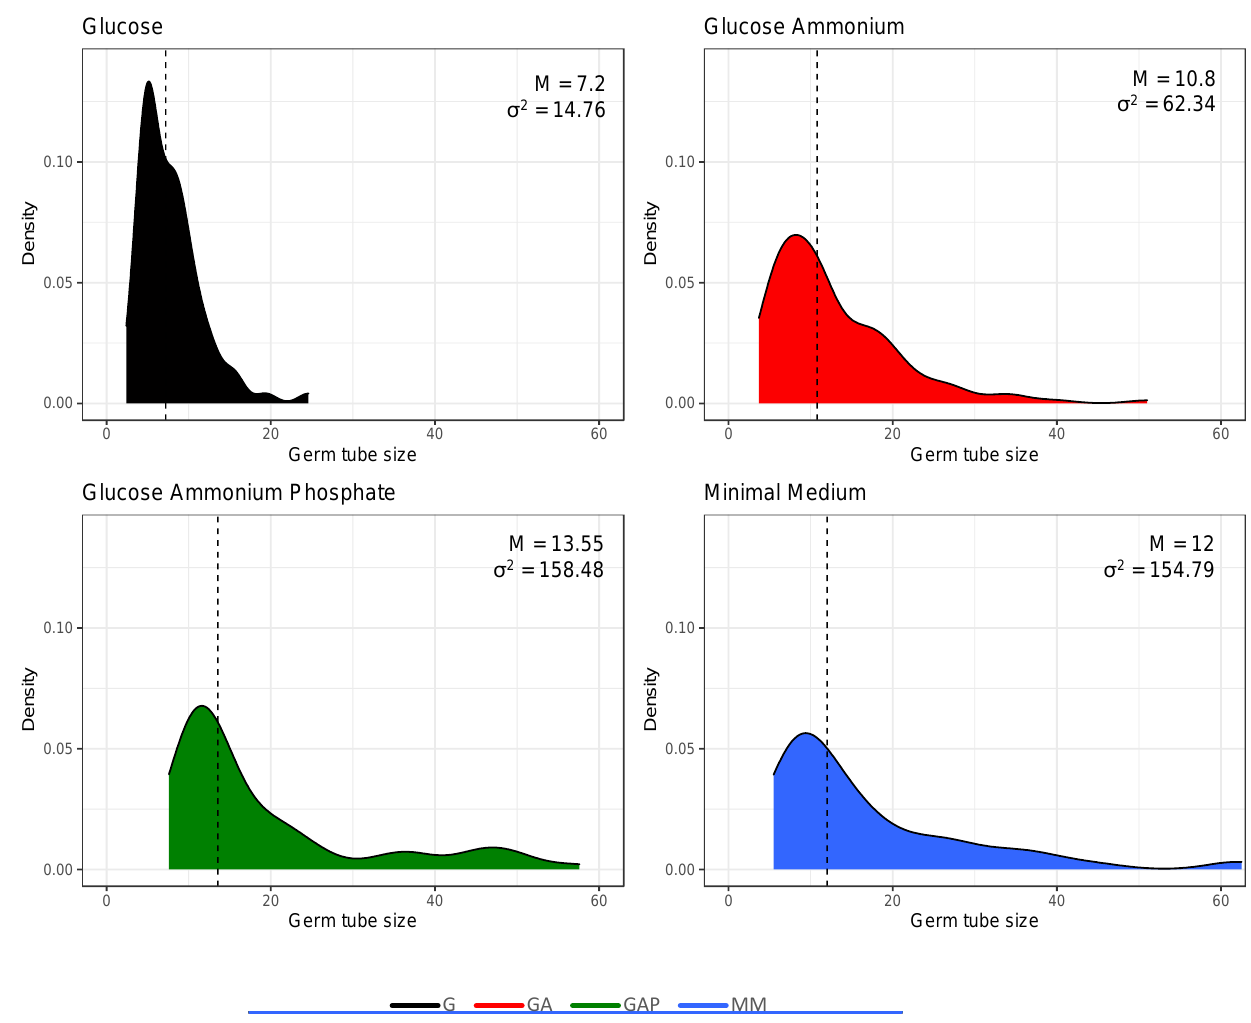
Figure 5. Heterogeneity in the population of germinated conidia estimated by the size of the germ tubes (in µm) in the different media. Incubation time was 24 hours in G, GA, GAP and 11 hours in MM. Median values and variance are shown in the upper right corner of each plot.